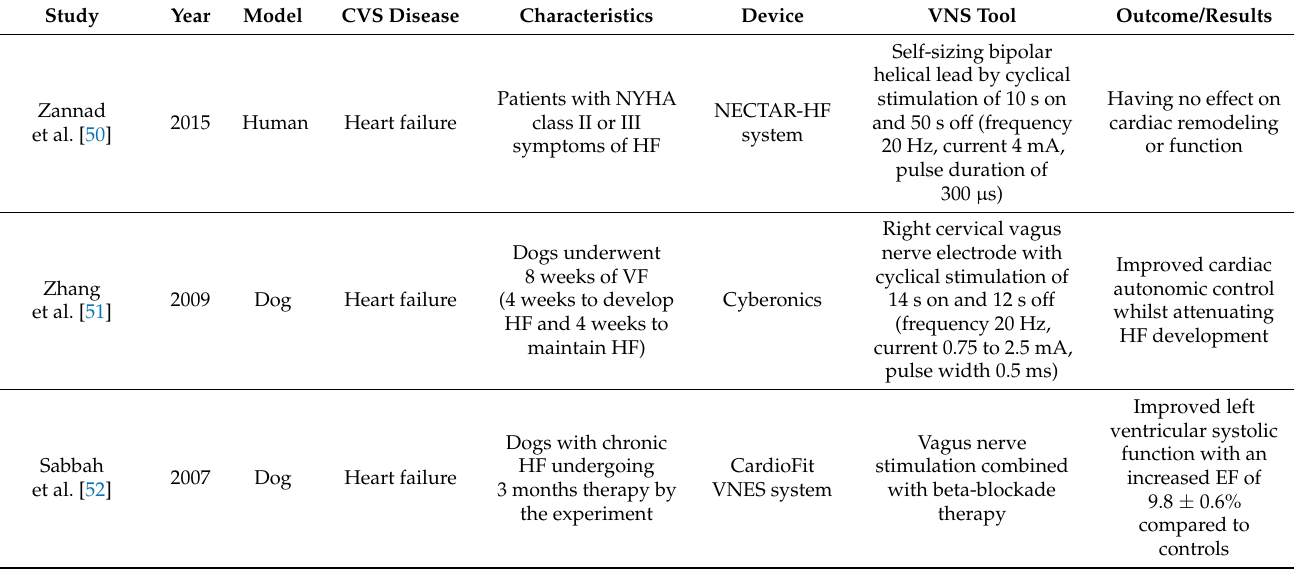
Table 5. Studies on different sVNS techniques in various applications. (PCI—Percutaneous